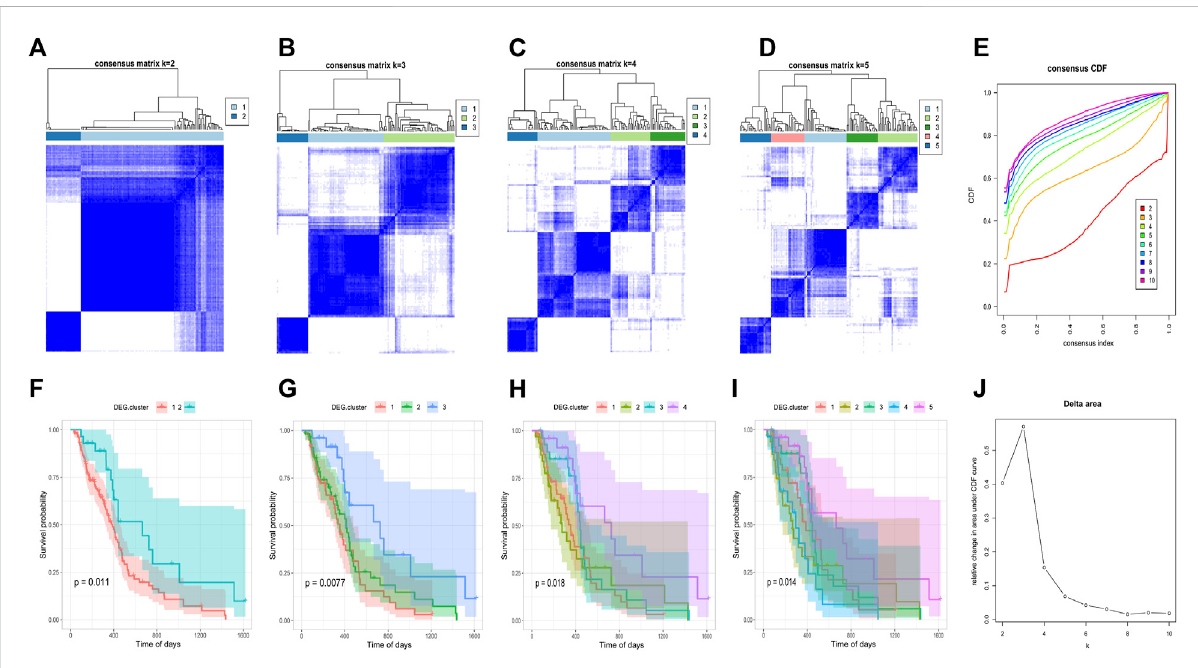
FIGURE 6 Consistent clustering of DEG. cluster-1 and -2 subgroups. (A – D) Sample clustering heat map when k = 2, k = 3, k = 4, k = 5, respectively. (F – I) Kaplan – Meier survival curves with k = 2, k = 3, k = 4, k = 5, respectively. (E) CDF curve distribution of consistency clustering. (J) Distribution of area under the CDF curve for consensus